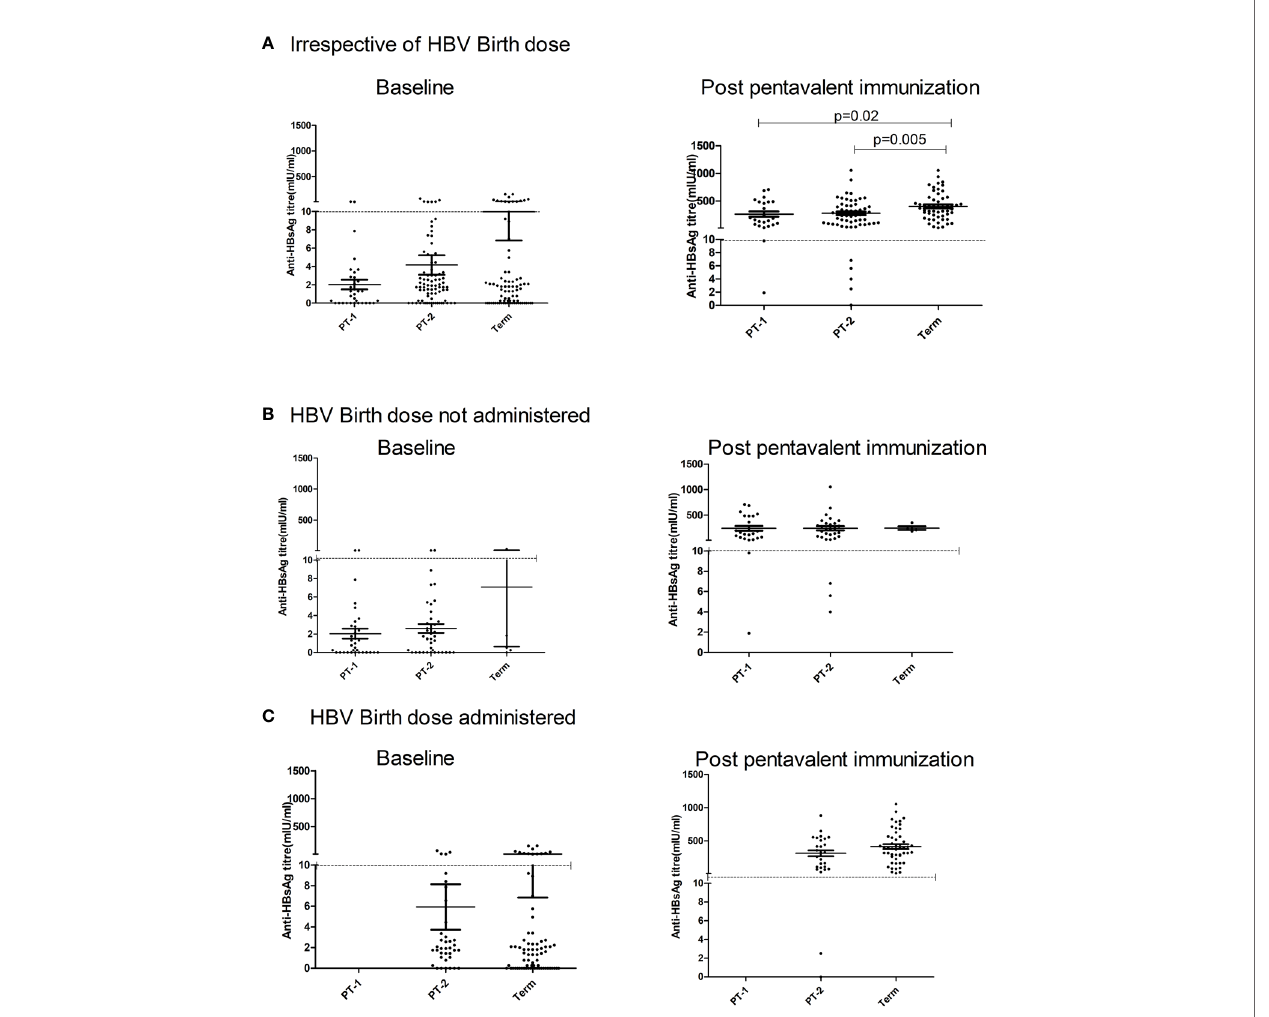
FIGURE 4 | Effect of administration of Hepatitis B Vaccine dose at birth on anti-HBs titers at pre and post pentavalent vaccination. Hepatitis B vaccine birth dose is administered to infants weighing ≥ 2000 g. Pre (baseline) and post-pentavalent vaccination anti-HBs titers are depicted with respect to the administration of birth dose: (A) (Irrespective of birth dose), (B) (no birth dose administered) and (C) (birth dose administered). The vertical scatter dot plots in the fi gure represent the antibody titers against HBsAg at pre and post pentavalent visits. Dotted line in the graph indicates the seroprotective antibody titers. Error bars- Mean with